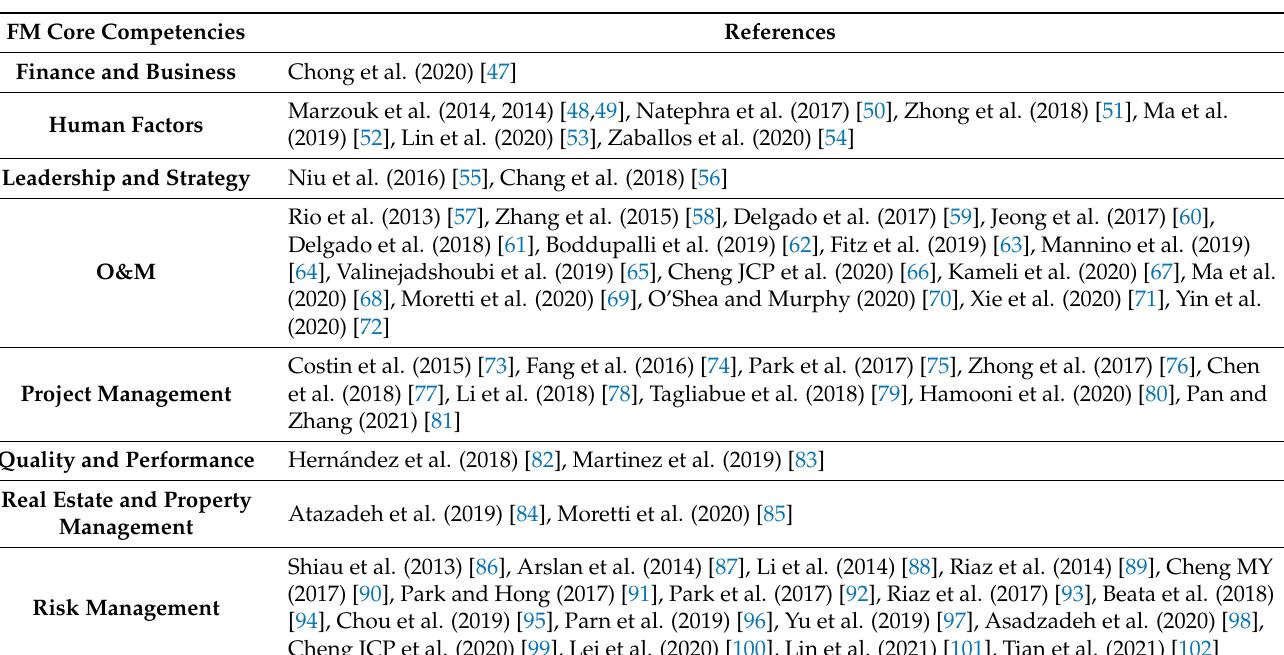
Table 8. Selected articles assignment to a single FM core function according to the title and abstract analysis made by the